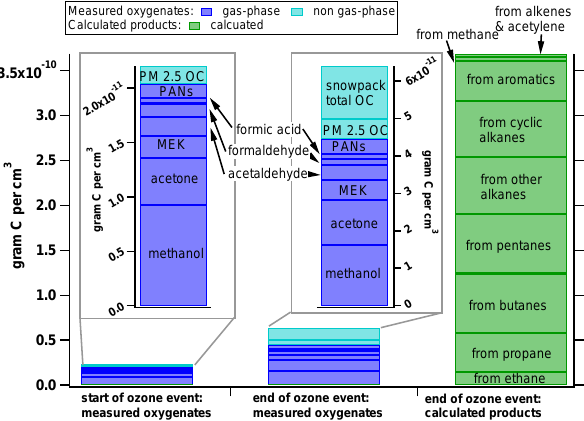
Figure 10. Organic carbon mass of oxygenated and secondary species. The two leftmost bars show the carbon mass of secondary species at the beginning (average of first 12h) and end (average of last 12h) of the ozone event; speciation is detailed in the two insets. Although methanol and formaldehyde may have primary sources, they are included here in the “product compounds” category to show the maximum contribution of these species to measured products. The rightmost bar shows the calculated mass of secondary com- pounds at the end of the ozone event; within this bar, the contribu- tion from each precursor is delineated.